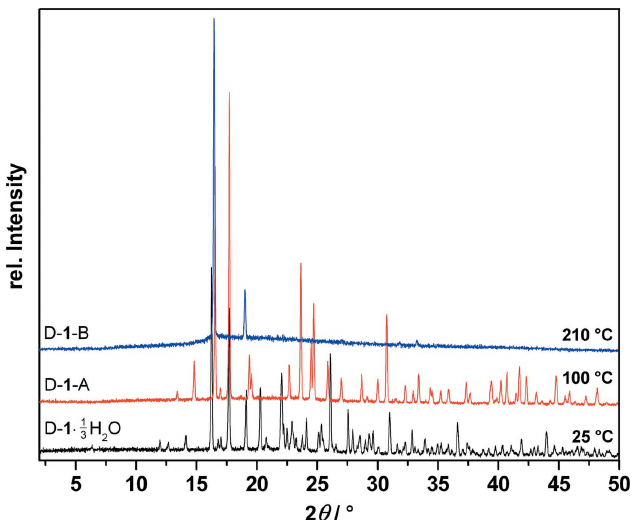
Figure 3 Temperature-dependent X-ray powder diffraction traces of d -(+)- chiro - inositol ( d - 1 ) at 25, 100 and 210 (cid:2) C showing the phase transitions from the 1/3 hydrate (black) ( d - 1 (cid:4) 1/3H 2 O) to the anhydrate (red) ( d - 1 -A) and to the high-temperature polymorph (blue) ( d - 1 -B).